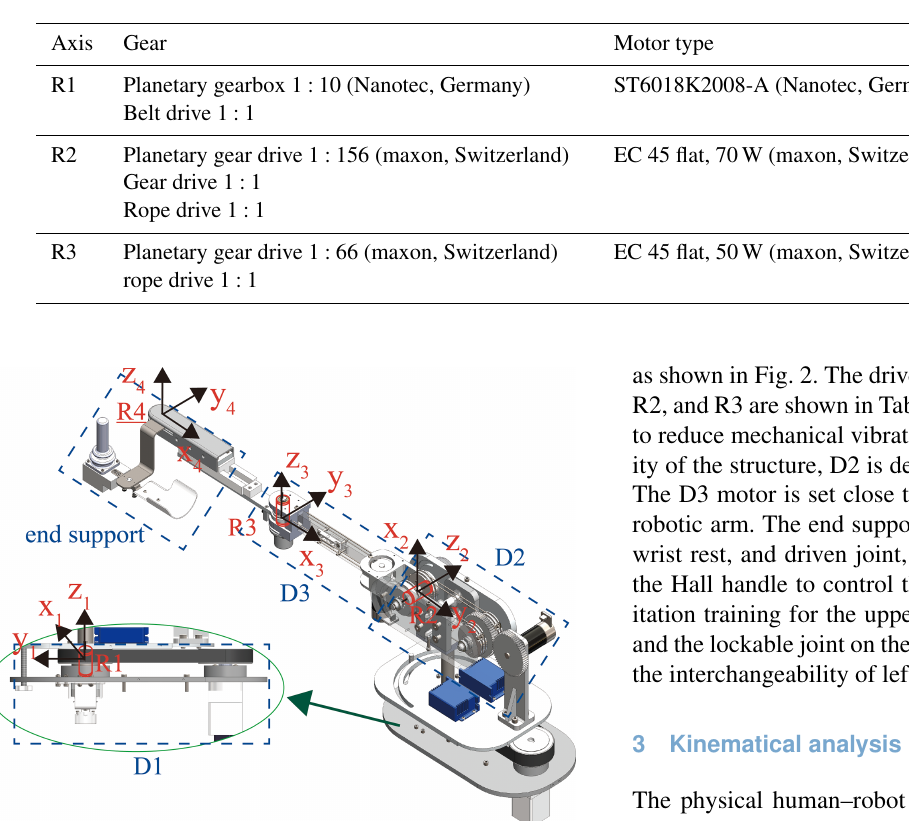
Figure 1. The configuration of robot and the human–machine closed-chain mechanism. Table 1. Actuation of the robot.